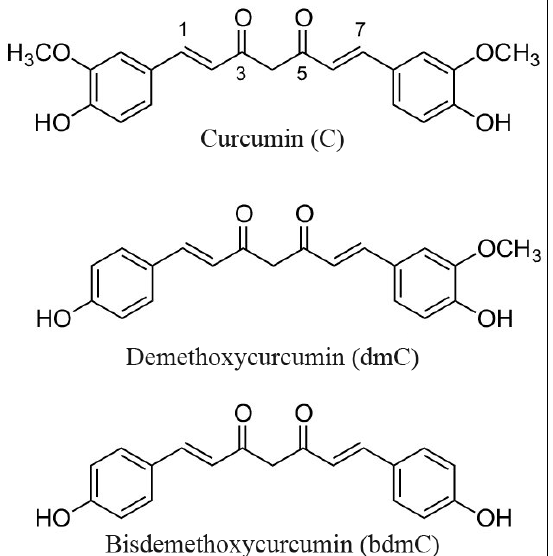
Figure 1. Chemical structure of curcumin, demethoxycurcumin, and bisdemethoxycurcumin.